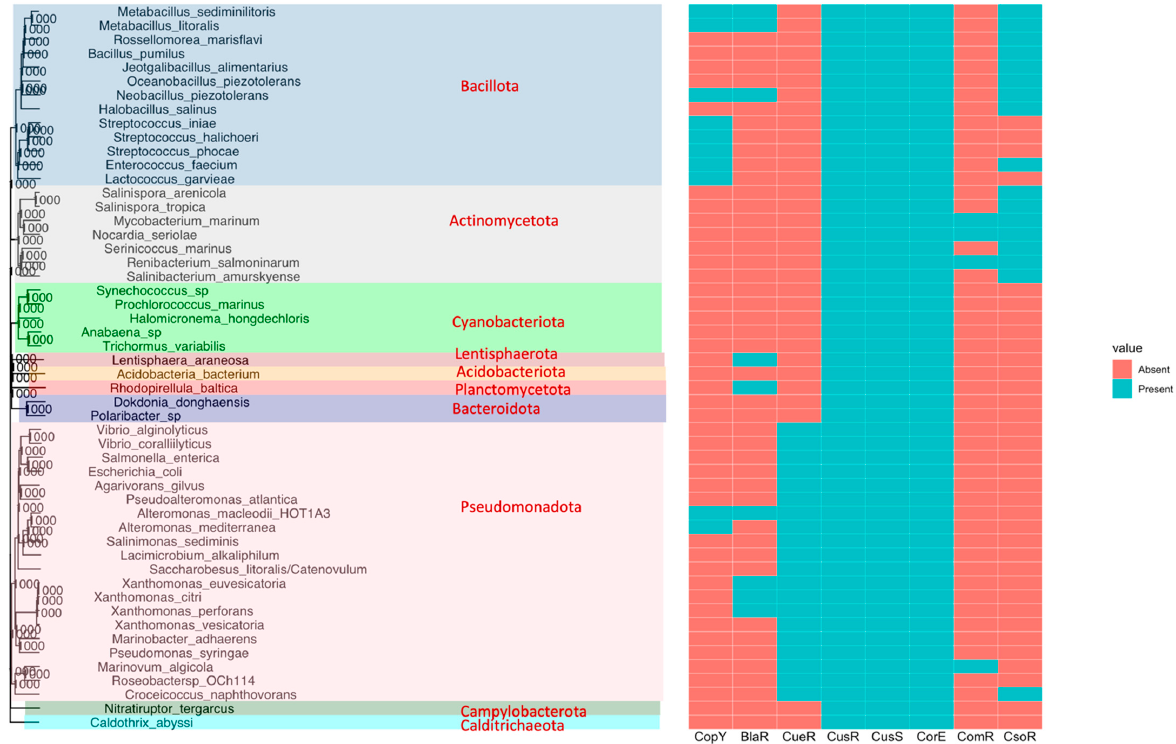
Figure 2. Distribution of copper-associated regulatory systems in marine bacteria from various phylogenetic groups. The nucleotide sequence of the full-length 16S ribosomal RNA sequence of rep- resentative marine bacteria was downloaded from the NCBI database. Multiple sequence alignment and phylogenetic analysis (bootstrap of 1000 by neighbor-joining algorithm) were performed in R. The possession of the copper-associated signal transduction system homologs in each organism was mapped onto the phylogenetic tree by using